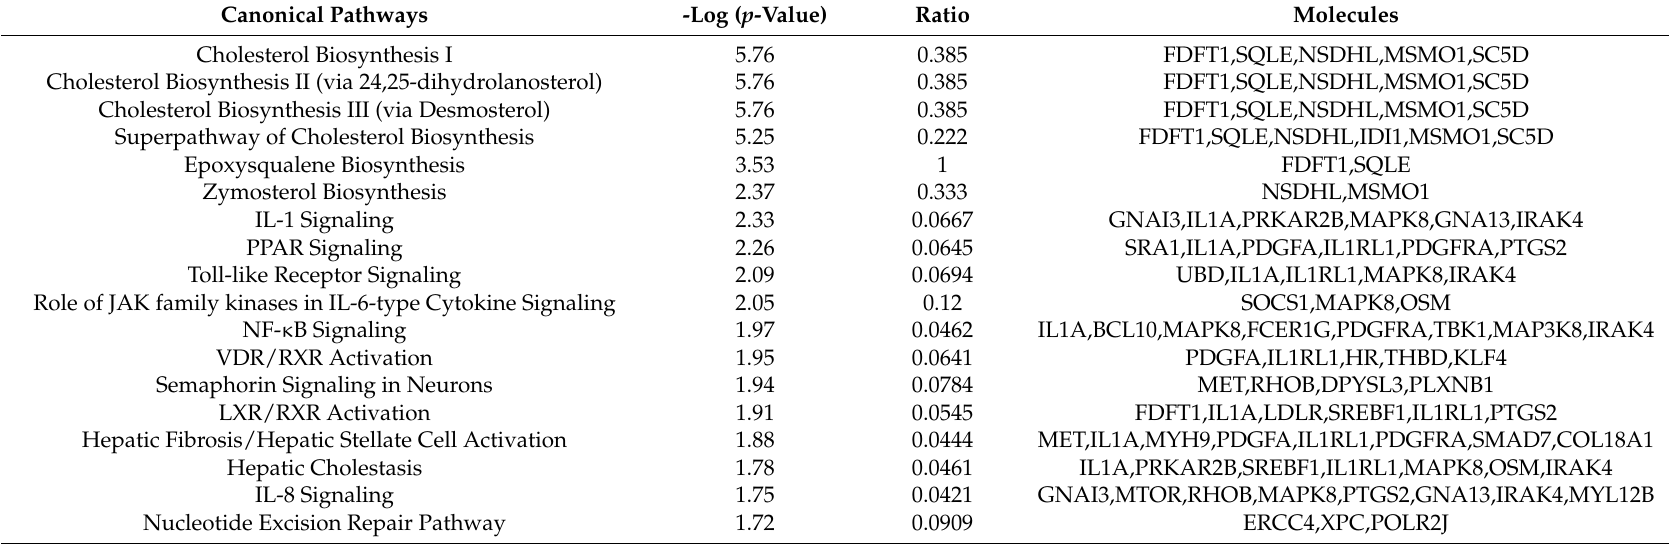
Table 3. Pathways represented among the DEG in GPO vs. CTR (Ingenuity Pathway (IPA)